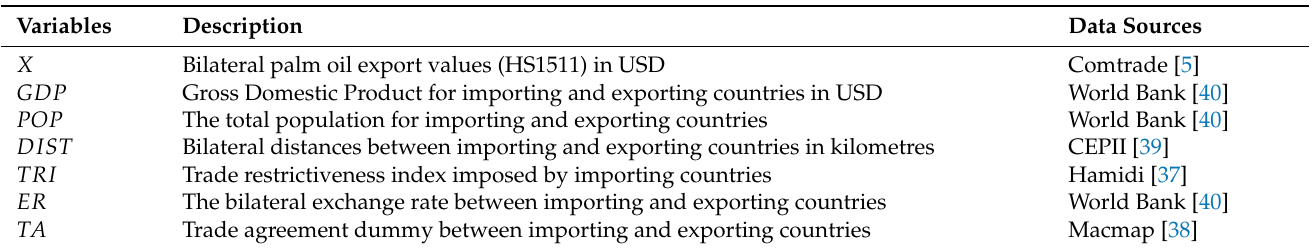
Table 1. Variable Description & Data